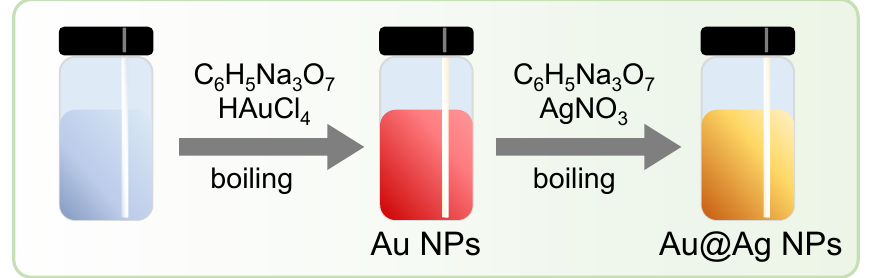
Scheme 1. Schematic diagram of the procedure for synthesis of Au@Ag NPs.